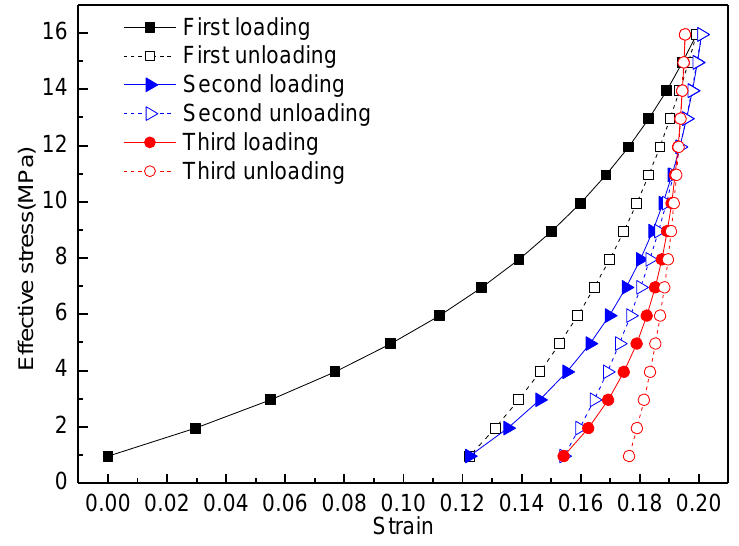
Figure 11. Stress-strain curves of coal samples under cyclic loading and unloading conditions.